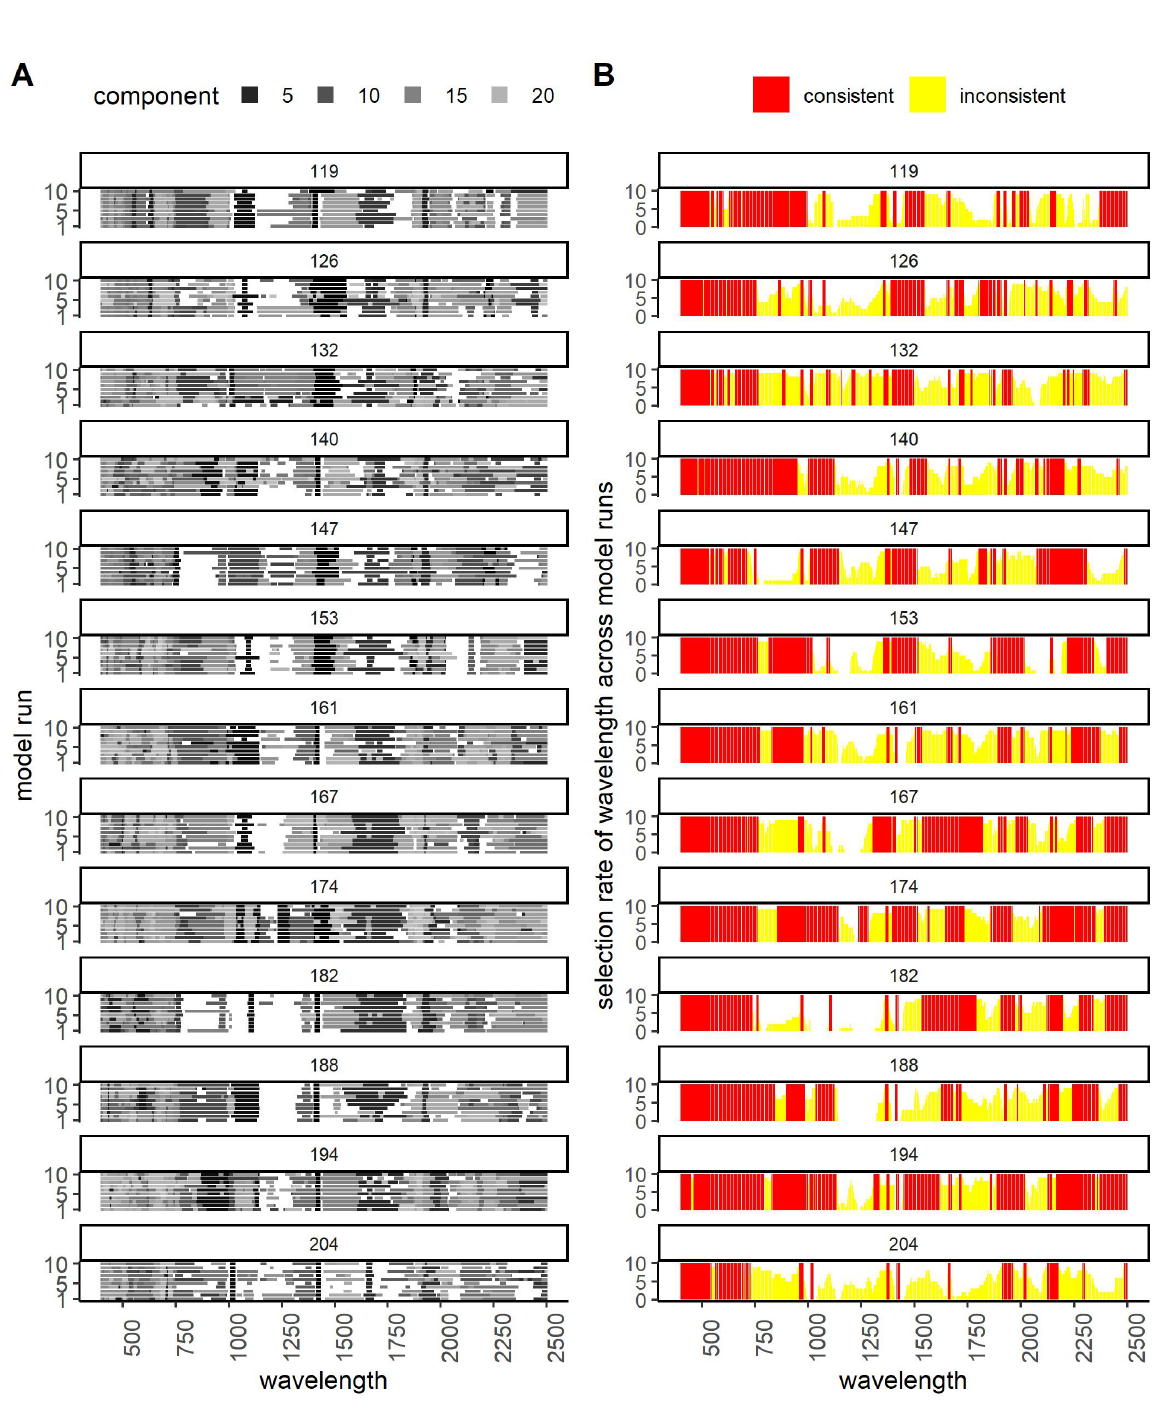
Figure 4. ( A ) The position within the spectra of components (latent variables) that were used for species–class determination for the 13 dates (day of year presented in the banner header). The darkest greys indicate components that captured more variations in the spectral data. ( B ) The selection rate of wavebands for model runs within each sampling date. Red bars represent wavelengths that were consistently selected in 10/10 runs; yellow bars are those that were only selected for some of the model